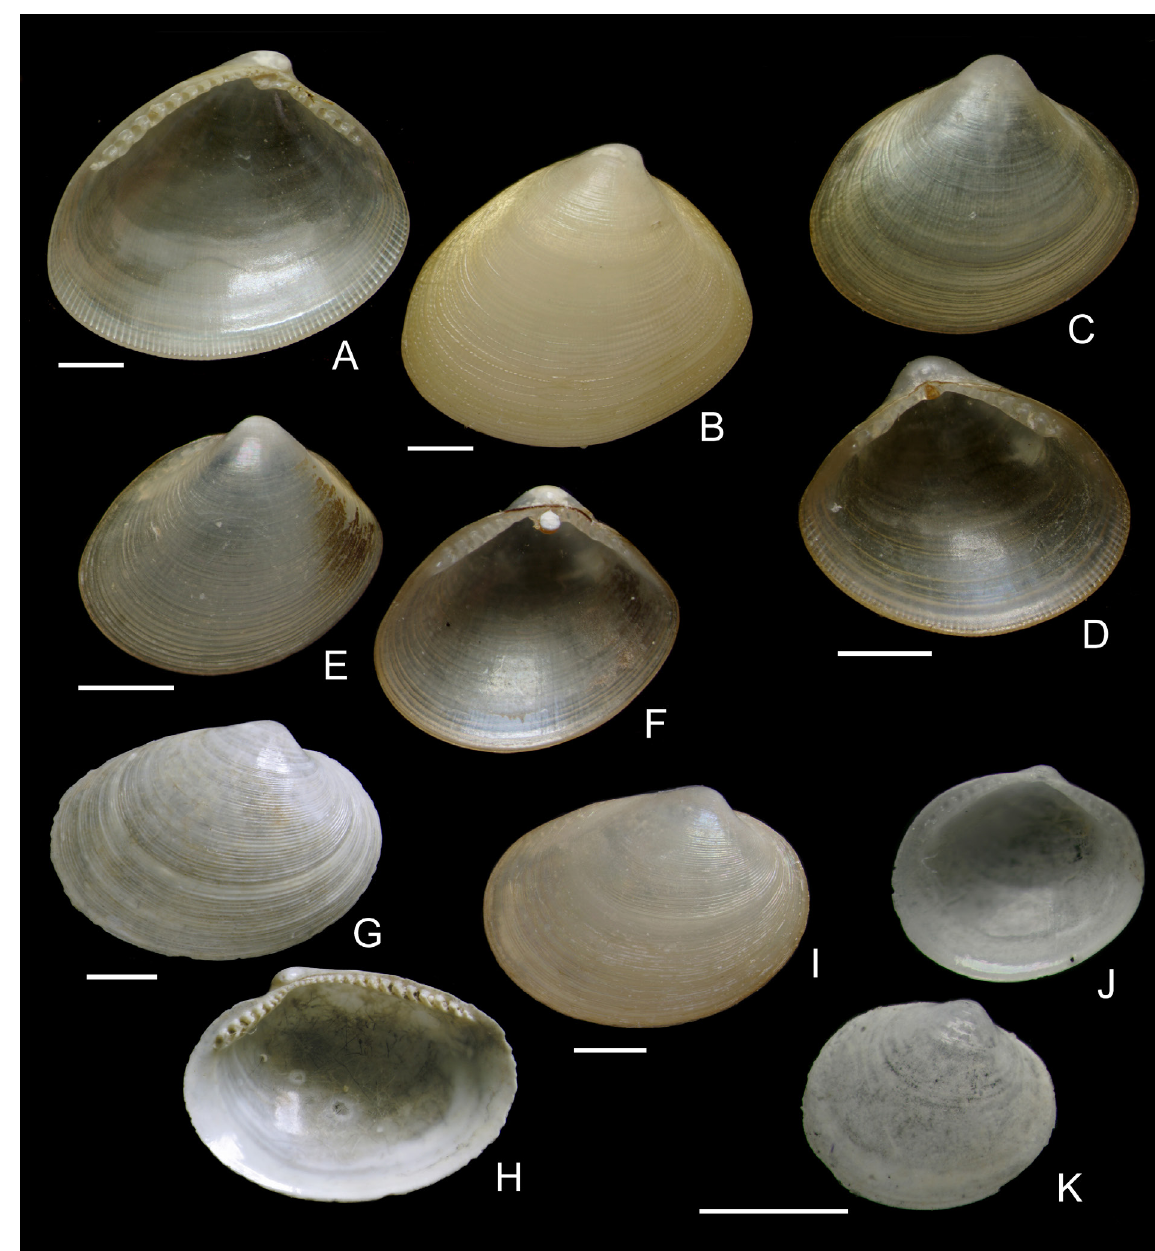
Fig. 31. Protobranchia 1. A–B . Nucula tumidula Malm, 1861, BANGAL 0711, V5, 1631 m, 5.5